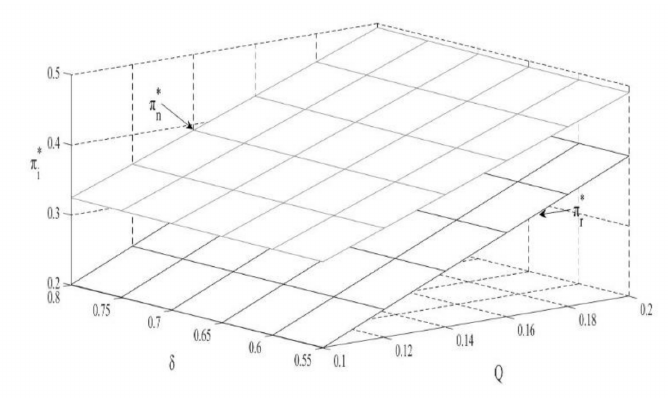
Figure 4. The impact of Q and δ on the